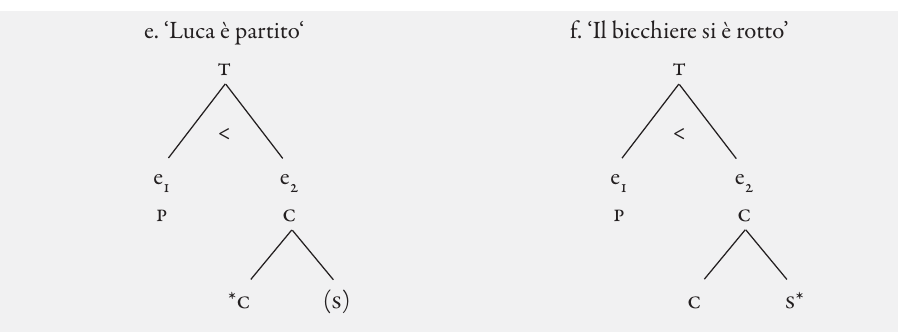
Figura 2 . Rappresentazione formale degli eventi telici con focus sul cambiamento e di quelli con focus sullo stato